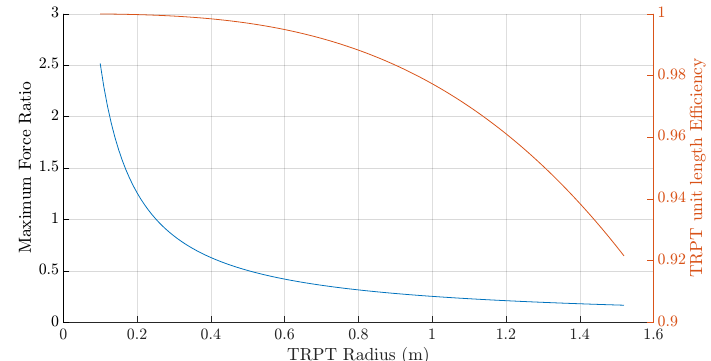
Figure 29. Maximum force ratio and TRPT efficiency versus TRPT radius.